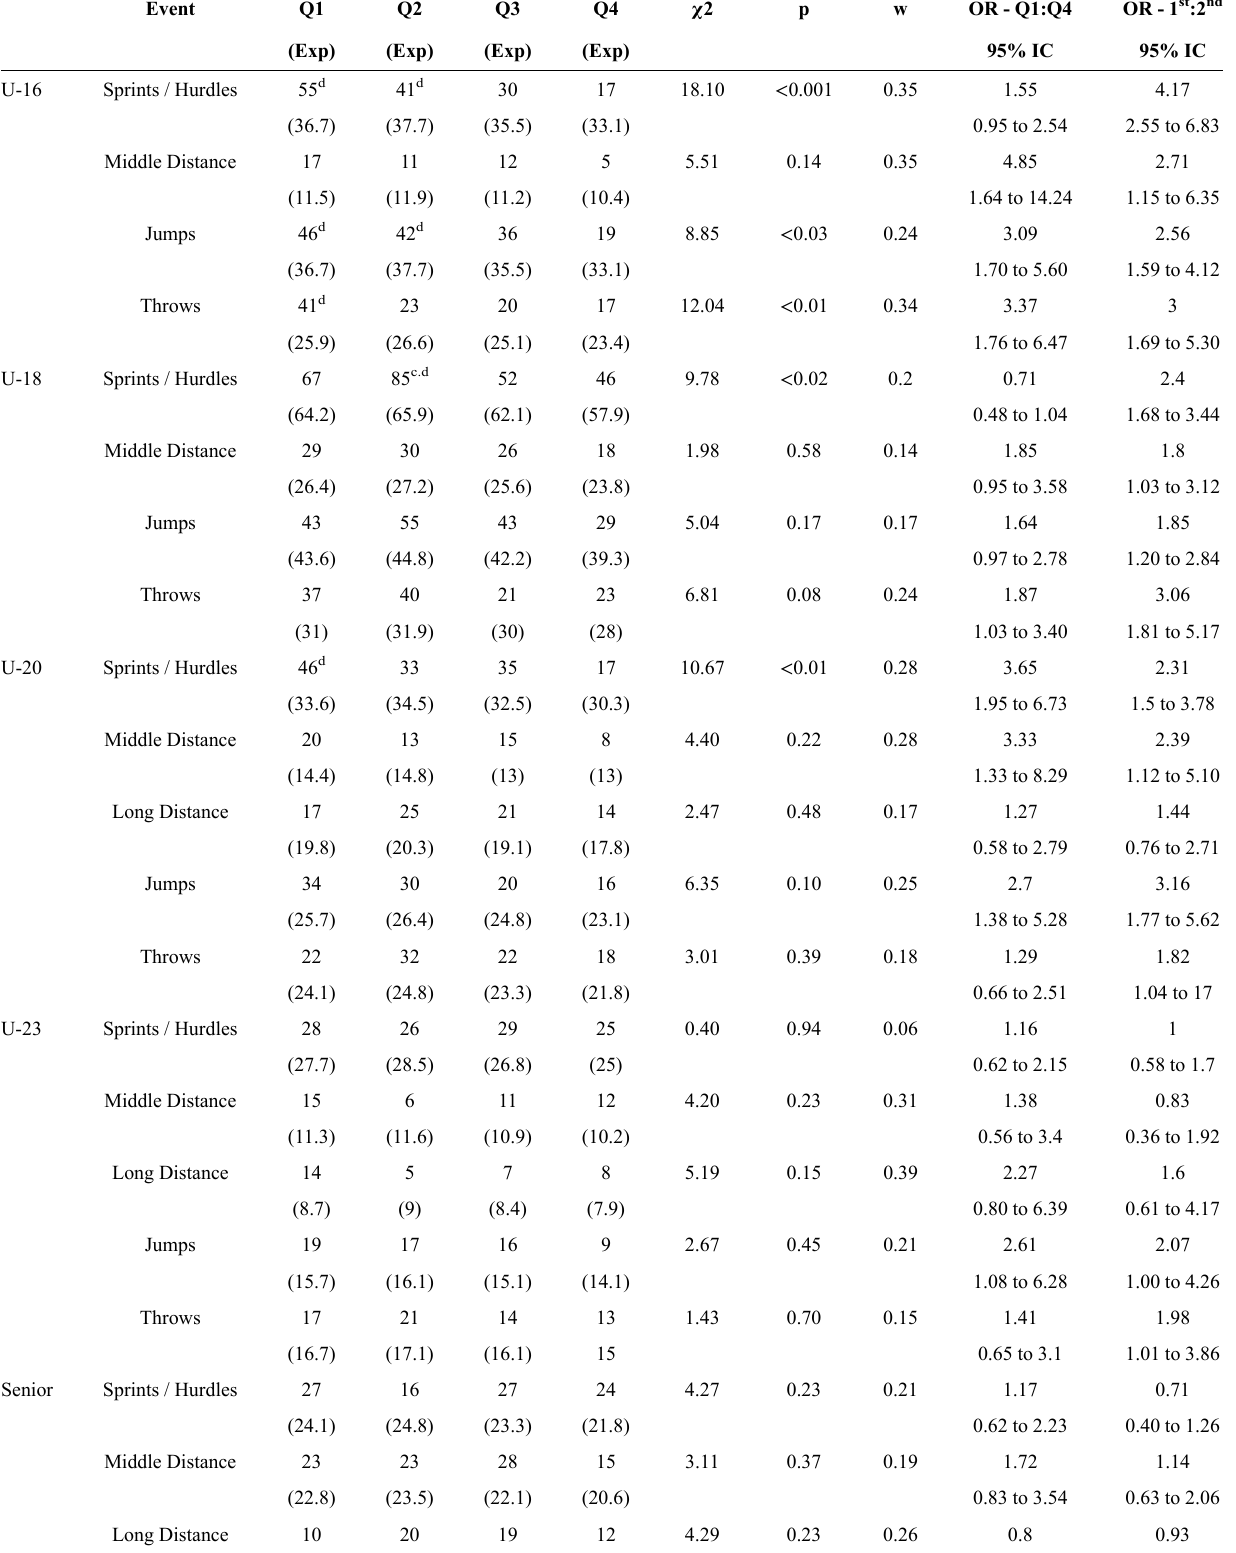
Table 1 - Quarter of birth distribution of male Brazilian Track and field athletes’ by age category and